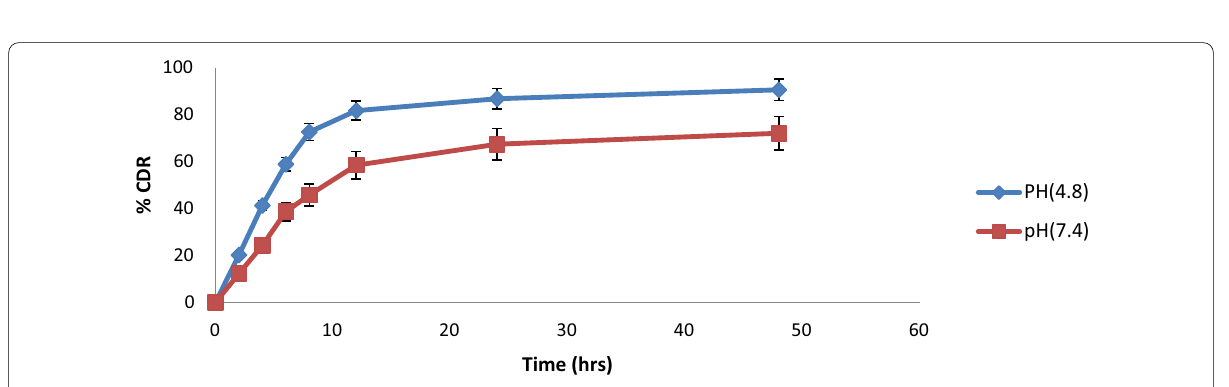
Fig. 6 Optimized formulation of gallic acid